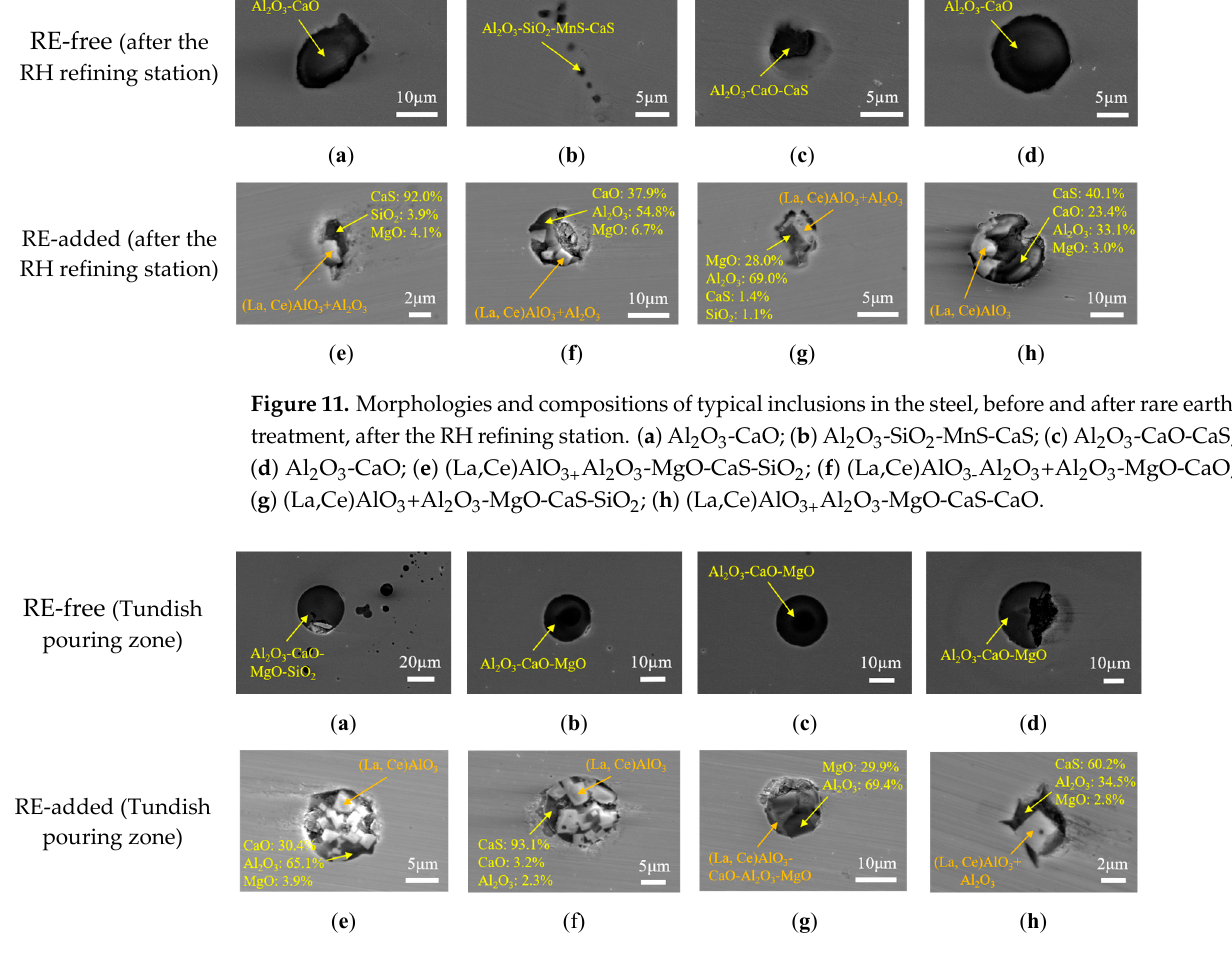
Figure 12. Morphologies and compositions of typical inclusions in the steel, before and after rare earth treatment, in the tundish pouring zone. ( a ) Al 2 O 3 -CaO-MgO-SiO 2 ; ( b ) Al 2 O 3 -CaO-MgO; ( c ) Al 2 O 3 -CaO-MgO; ( d ) Al 2 O 3 -CaO-MgO; ( e ) (La,Ce)AlO 3+ Al 2 O 3 -MgO-CaO; ( f ) (La,Ce)AlO 3 +Al 2 O 3 -CaS-CaO; ( g ) (La,Ce)AlO 3 +Al 2 O 3 -MgO; ( h ) (La,Ce)AlO 3 -Al 2 O 3 +Al 2 O 3 -MgO-CaS